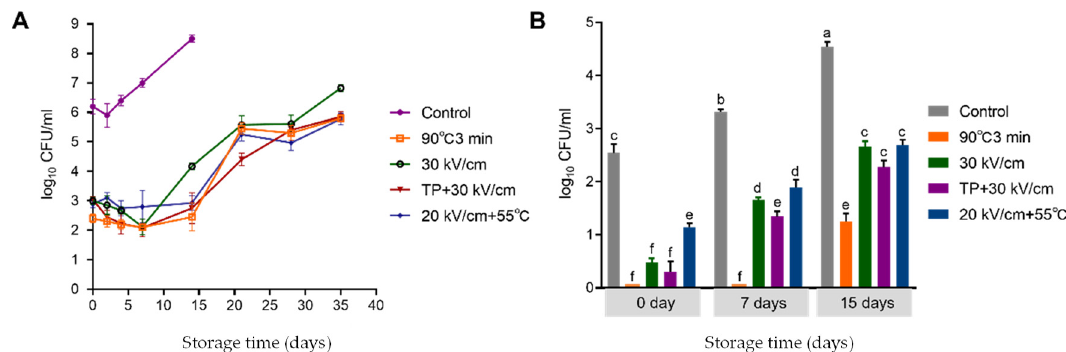
Figure 5. Microbial changes in PEF-treated cantaloupe juice stored at 4 ◦ C. ( A ) Changes of total aerobic bacteria in PEF-treated cantaloupe juice stored at 4 ◦ C. ( B ) Changes in yeast and mold in PEF-treated cantaloupe juice stored at 4 ◦ C. Data are expressed as mean ± standard deviation. Significant differences are indicated by different letters ( p < 0.05). Control, untreated cantaloupe juice; 90 ◦ C, treated at 90 ◦ C for 3 min; 30 kV/cm, treated at 30 kV/cm for 400 µ s; TP + 30 kV/cm, treated with 400 mg/kg tea polyphenols and then treated at 30 kV/cm for 400 µ s; 20 kV/cm + 55 ◦ C, treated at 20 kV/cm for 400 µ s and then treated at 55 ◦ C for 5